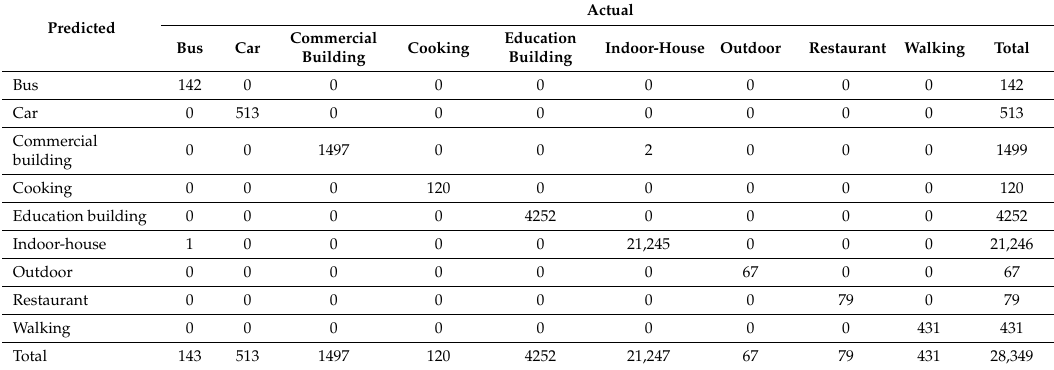
Table 5. Confusion table for test data simulation using statistical